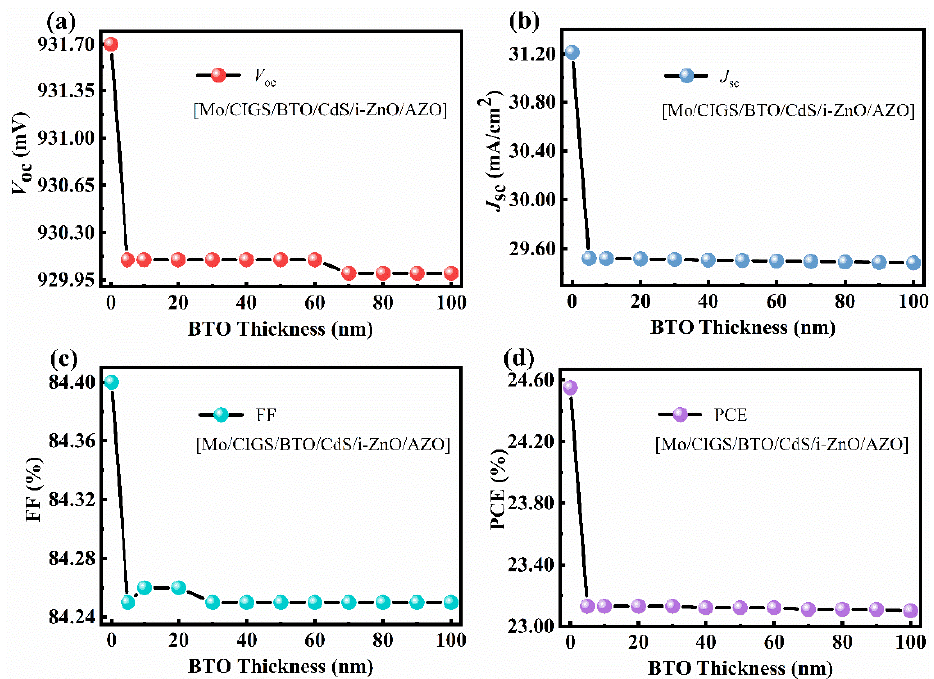
Figure 7. Dependence of ( a ) V oc , ( b ) J sc , ( c ) FF, and ( d ) PCE on the thickness of the BTO in the ferroelectric-coupled CIGS solar cell with a device structure of Mo/CIGS/BTO/CdS/i-ZnO/AZO.